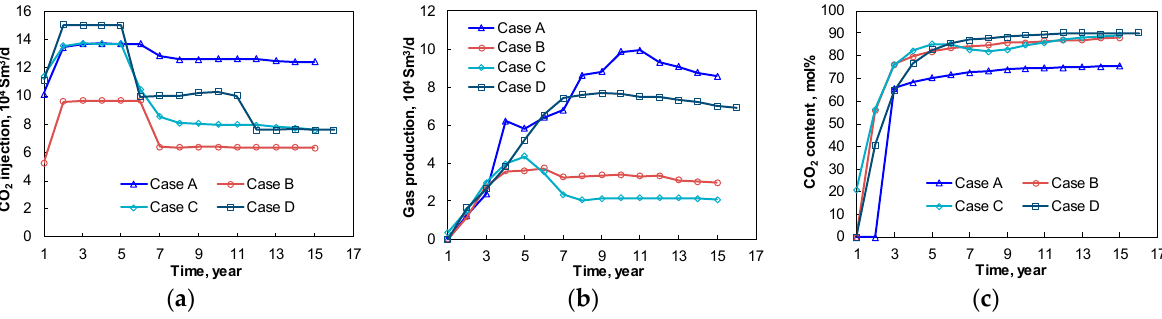
Figure 8. ( a ) Gas injection rate, ( b ) Gas production rate, and ( c ) CO 2 content in produced gas. The predicted gas injection and production in the CO 2 EOR and storage project in XinJiang oilfield.